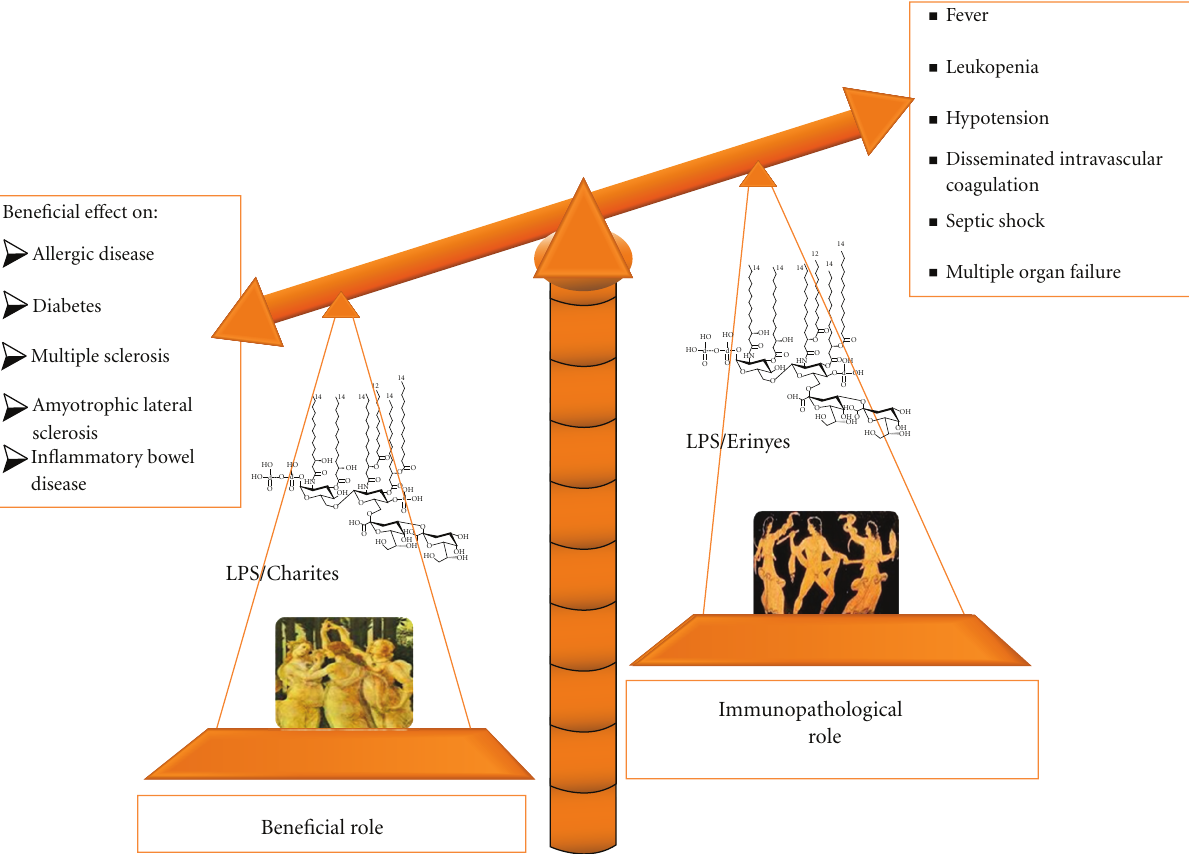
Figure 1: Balance between beneficial and immunopathological roles of